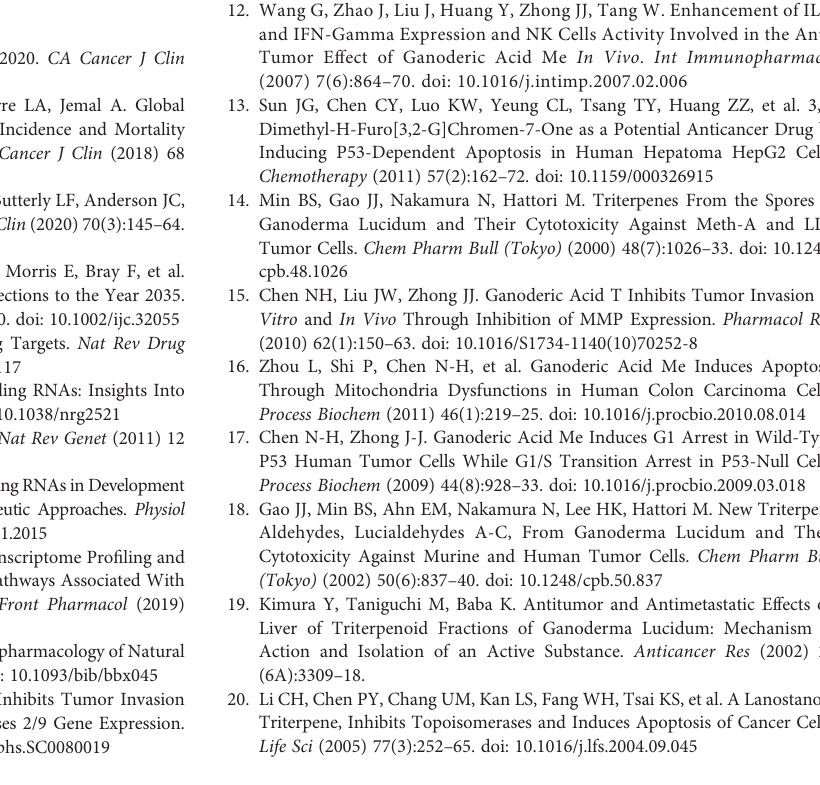
Supplementary Figure 3 | Scatter plot of the top 20 enriched KEGG pathways in GA-Me-treatedHCT116cells.Thetop20KEGGpathwaysenrichedamongthecis- targeted genes of DElncRNAs (A) , the trans-targeted genes of DElncRNAs (B) , the host genes that were downregulated (C) and upregulated by DEcirRNA targeting (D) , and the genes that were downregulated (E) and upregulated (F) by DEmiRNA targeting. The downregulated (G) and upregulated (H) DEmRNAs identi fi ed after GA-Me treatment are shown. The abscissa enrichment score represents the proportion of genes of interest in the pathway, and the ordinate represents each pathway. The size of the dots represents the number of genes annotated in the pathway, and the color of the dots represents the corrected p value of the hypergeometric test. KEGG, Kyoto Encyclopedia of Genes and